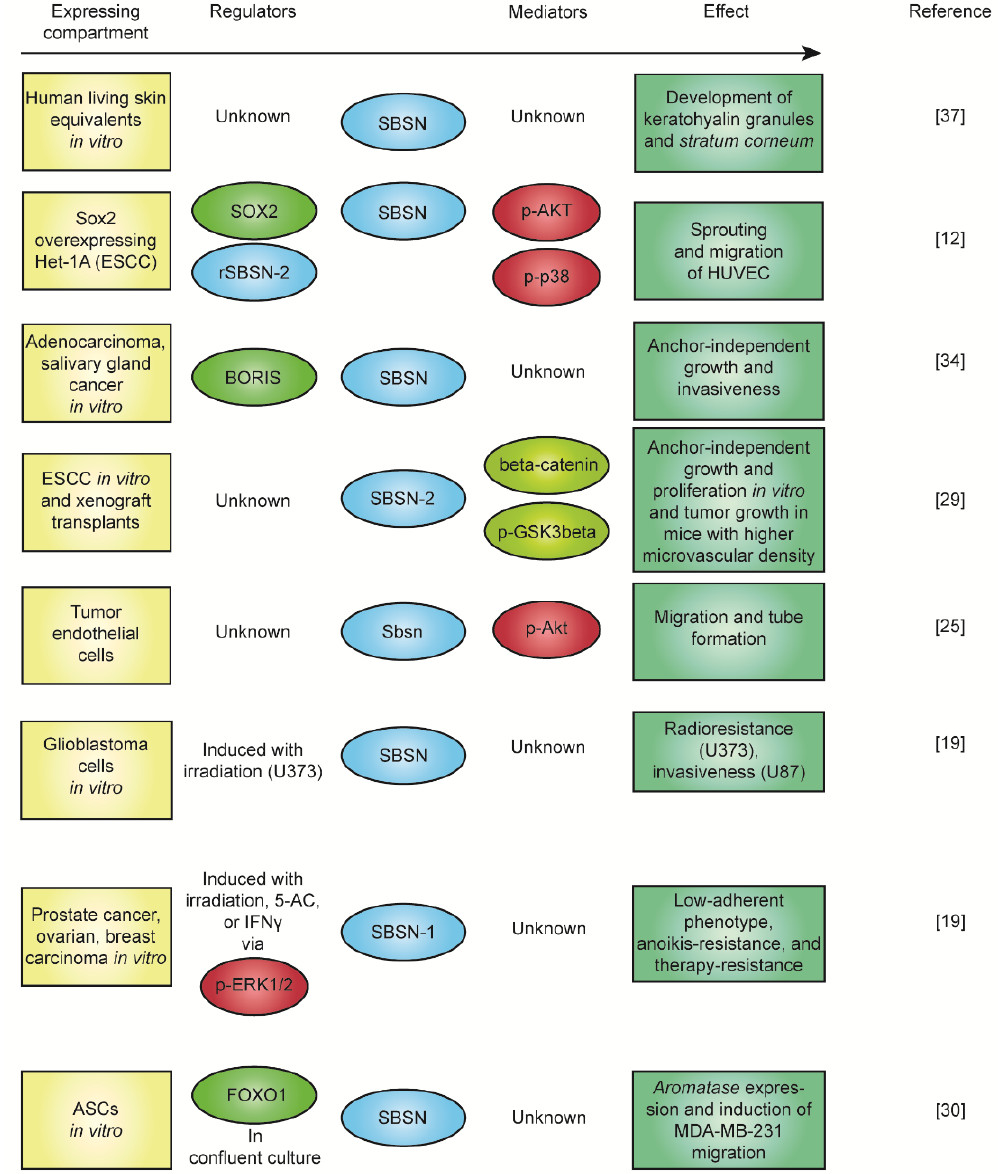
Figure 4. SBSN and observed effects in various models. SBSN and observed effects based upon results from compiled literature. ESCC: oesophageal squamous cell carcinoma; HUVEC: human umbilical vein endothelial cells; ASCs: adipocyte tissue-derived stem cells.